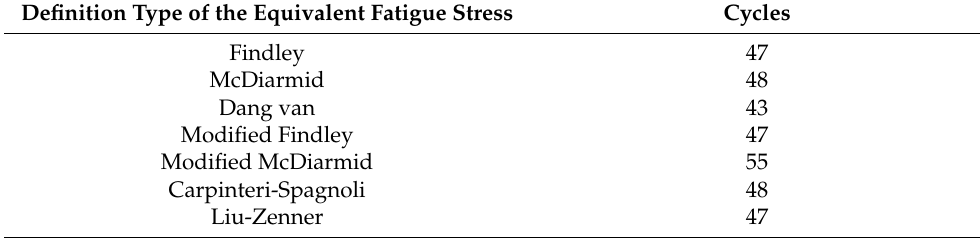
Table 4. Cycle-counting results of the rainflow technique for different equivalent stresses in element No. 38732.